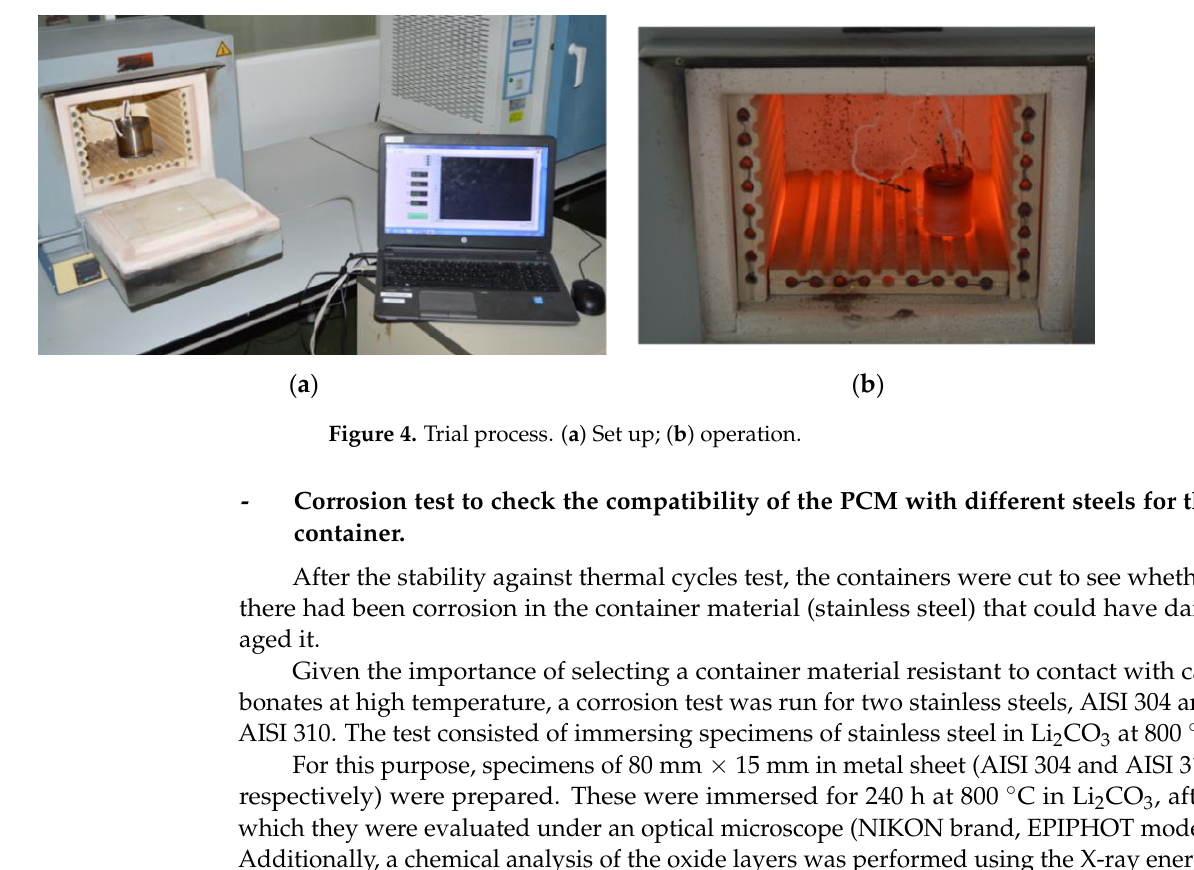
Figure 3. Assembly of the device with thermocouples.